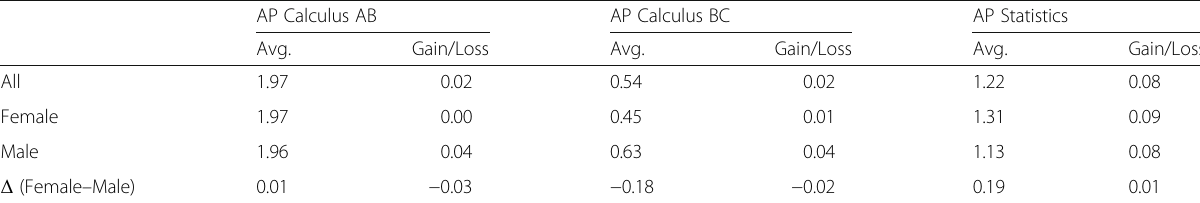
Table 8 Six-year average enrollment rates and gain/loss of enrollment by gender in AP Calculus AB, AP Calculus BC, and AP